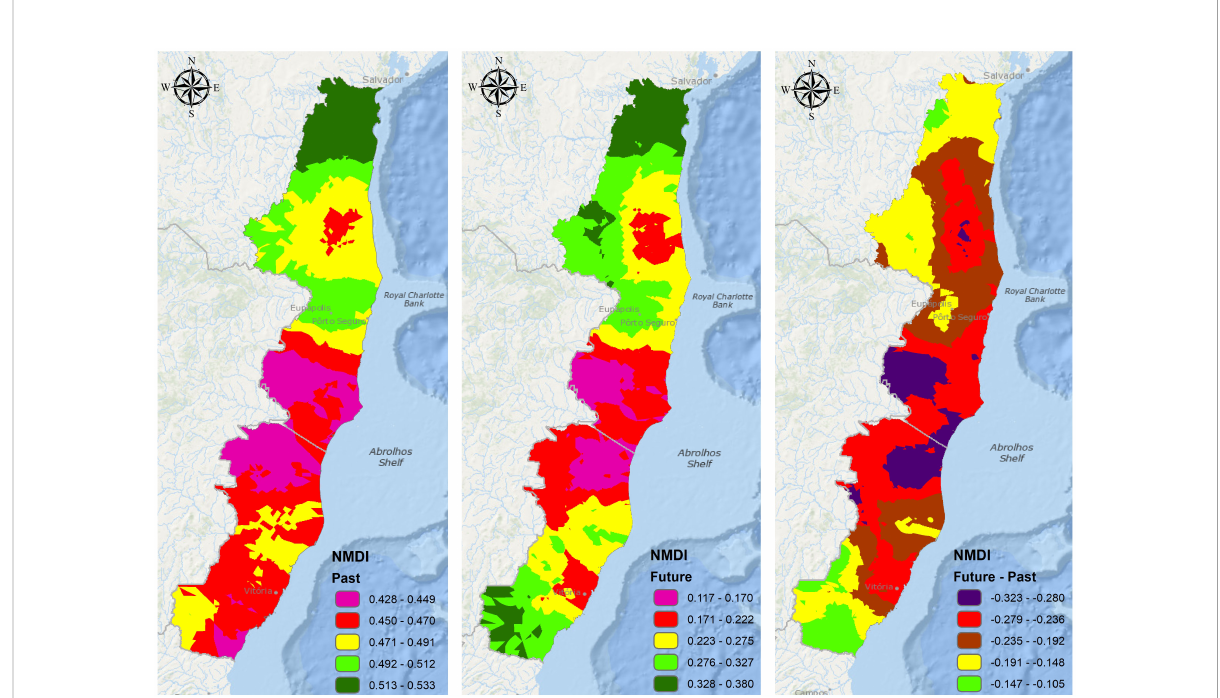
FIGURE 7 Spatial variation of the past, future simulation, and difference (future-past) of the normalized multi-band drought index (NMDI) in the Central Atlantic Forest Corridor,